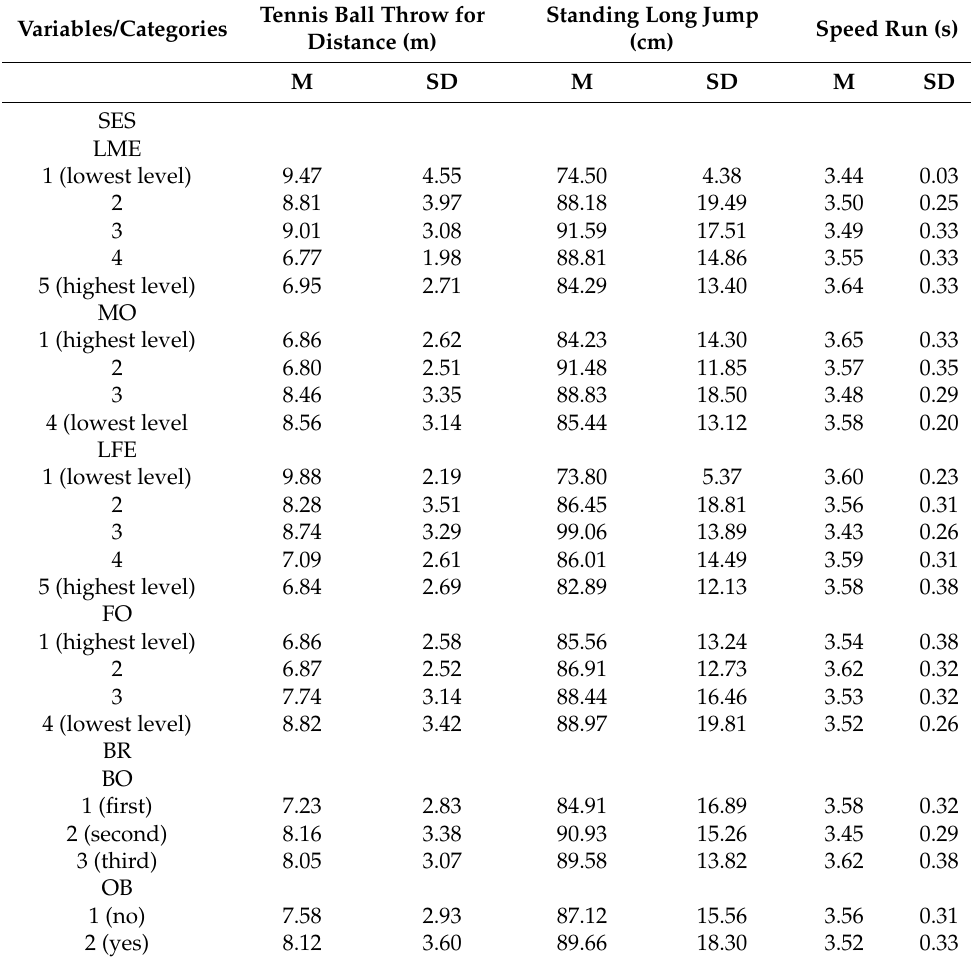
Table 1. Mean and standard deviation in each category of nominal predictor variables of each motor skill performance and in sum of